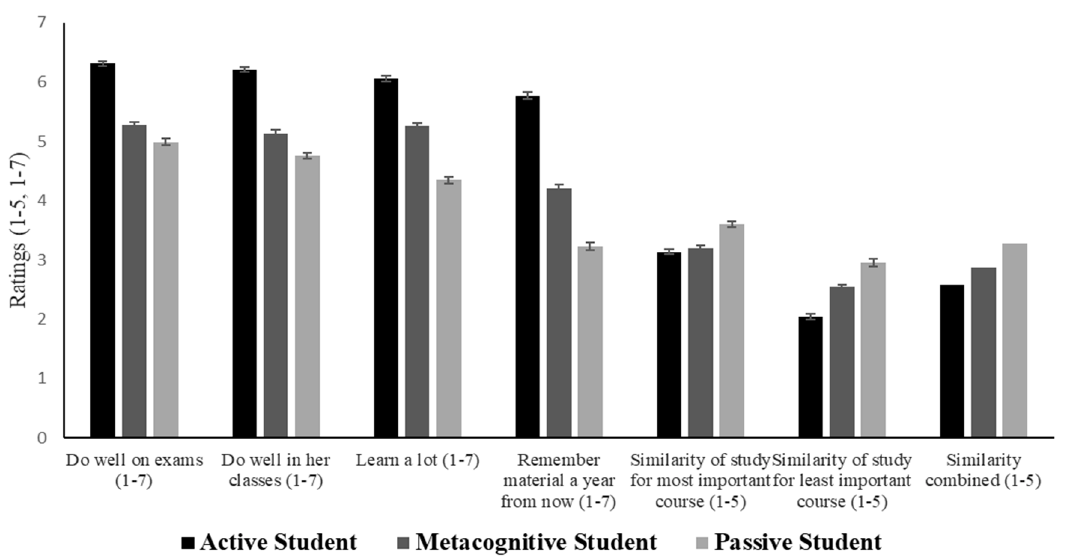
Figure 3. Means performance, learning, and similarity to own behaviors ratings, by vignette. Error bars represent one standard error.